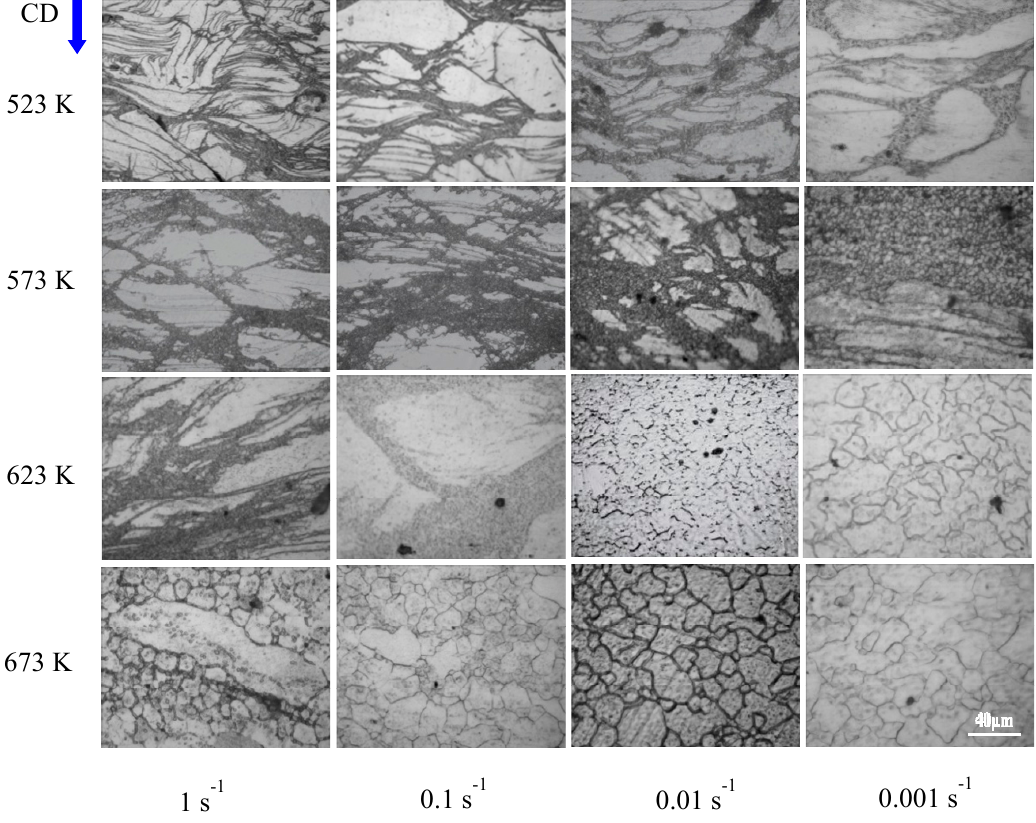
Figure 2. OM images of AZ91 alloy after hot compression. (CD represents compression direction).